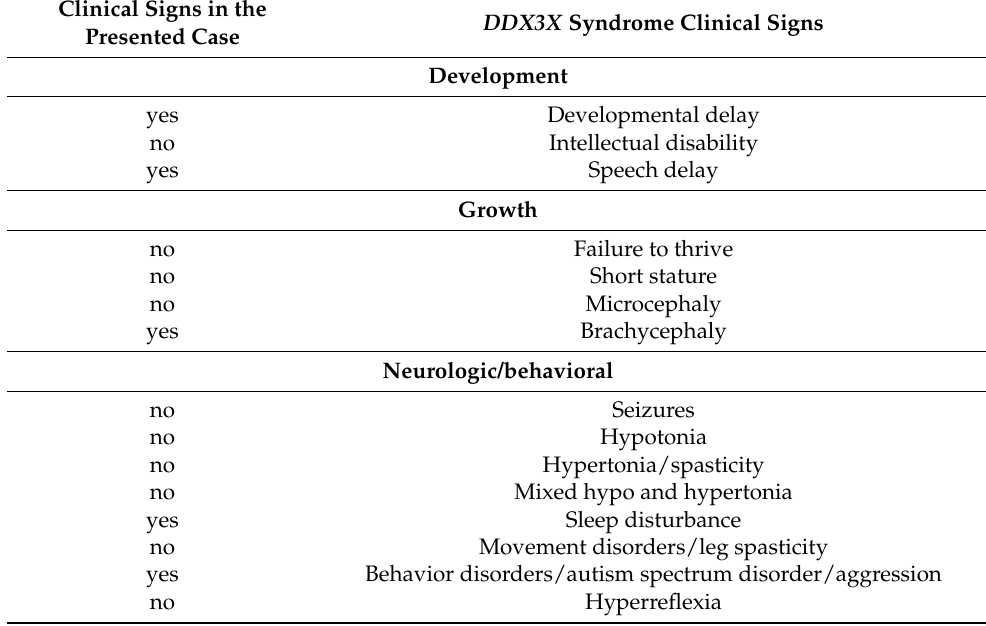
Table 1. Clinical features of the reported individual compared with the characteristics of clinical signs associated with DDX3X